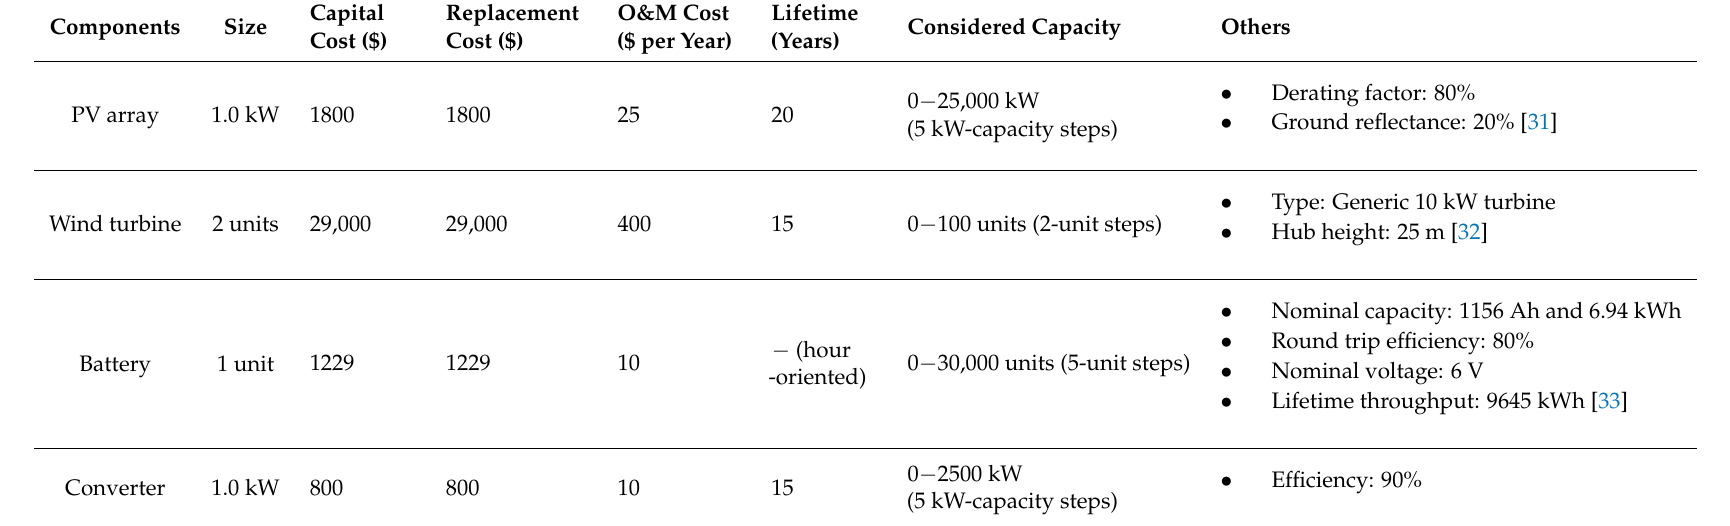
Table 4. Detailed economic and technical information of the components in the simulation [27–30] (O&M cost: Operation & Management cost; created by the authors).